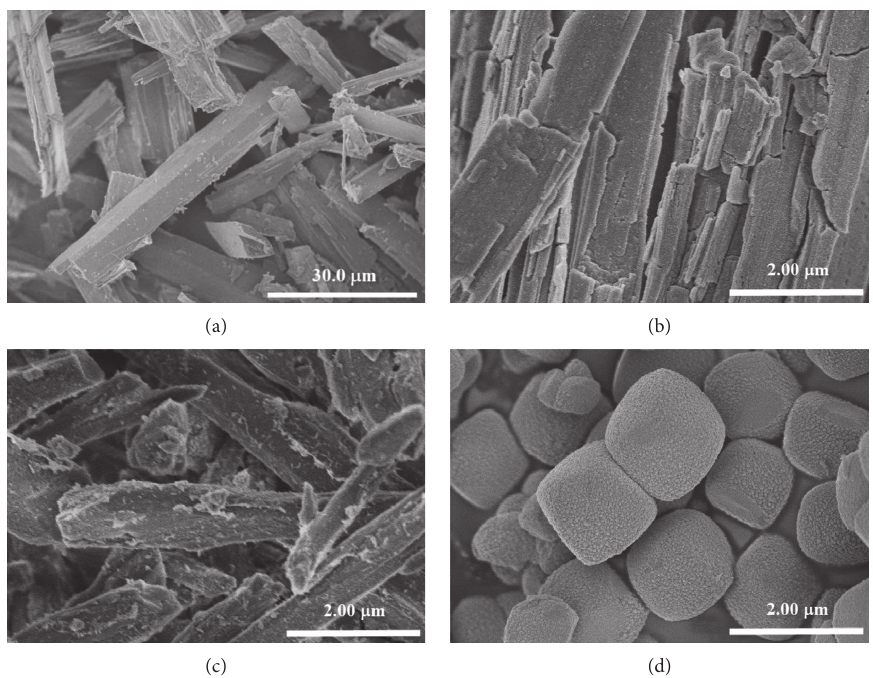
Figure 3: SEM images of iron (III) benzene dicarboxylate samples synthesized in DMF (a), (b), MeOH (c), and water (d).